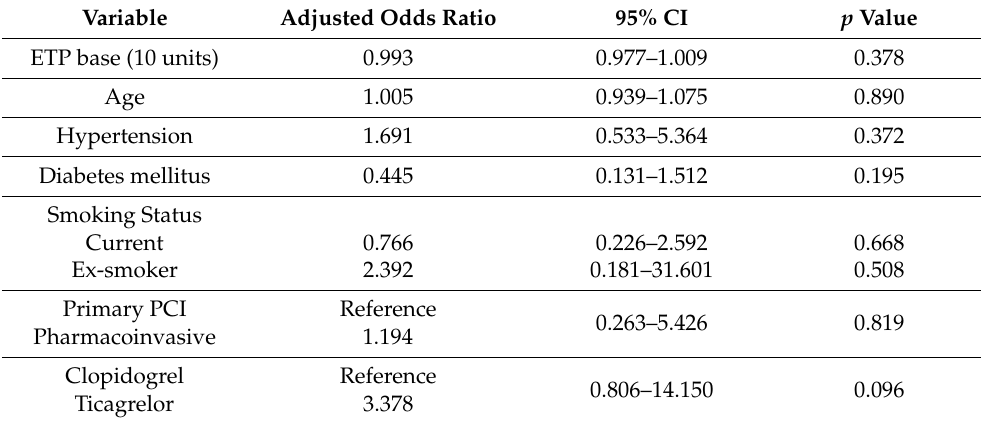
Table 6. Predictors of increase in left ventricular ejection fraction